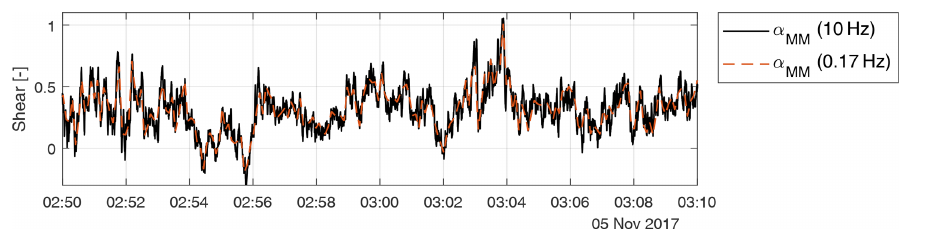
Figure 4. Time series of the met-mast-measured shear coefficient, at the original acquisition frequency of the cup anemometers (10Hz) and downsampled at 0 . 17Hz, which is the sector-effective wind estimation frequency for low rotor speeds.